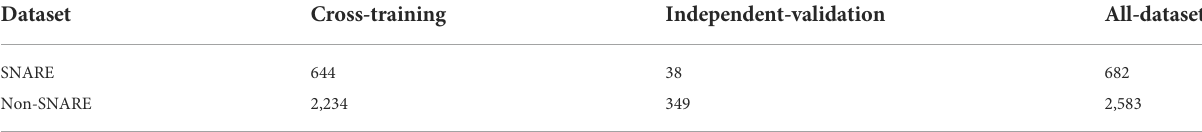
TABLE 1 Number of raw SNARE and non-SNARE proteins in the cross-training dataset, independent-validation dataset, and all-dataset.